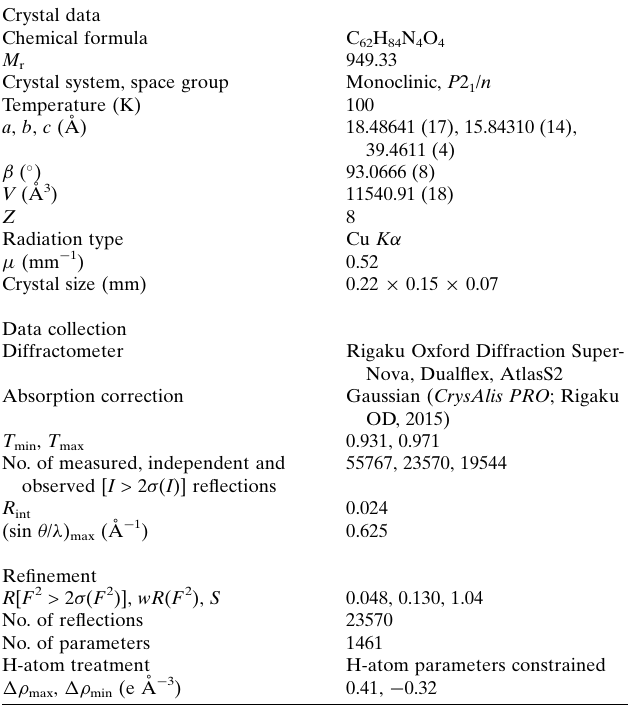
Table 2 Experimental details. Crystal data Chemical